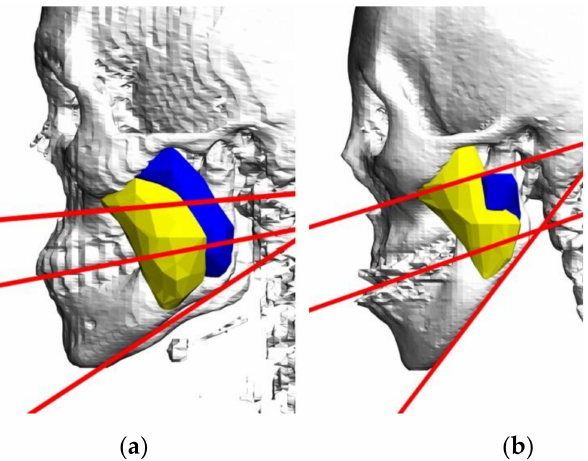
Figure 3. The angle between the masseter muscle and reference planes measured in the sagittal view of computed tomography. Information on the masseter muscle is shown in Figure 1. The upper red line is the palatal plane (ANS-PNS). The middle red line is the occlusal plane (Half distance point between the incisal edges of the maxillary and mandibular incisors and the mesial cuspid tips of the mandibular bilateral permanent first molars). The lower red line represents the mandibular plane (Go-Me). The angles between the superficial and deep masseter muscle and the three reference planes were measured. Superficial and deep masseter muscles and three reference planes of the ( a ) normal group and ( b ) prognathic group (Maya, version 2018, www.autodesk.com). Thirdly, the angle of the curve was measured using the “Measure Angle Tool”